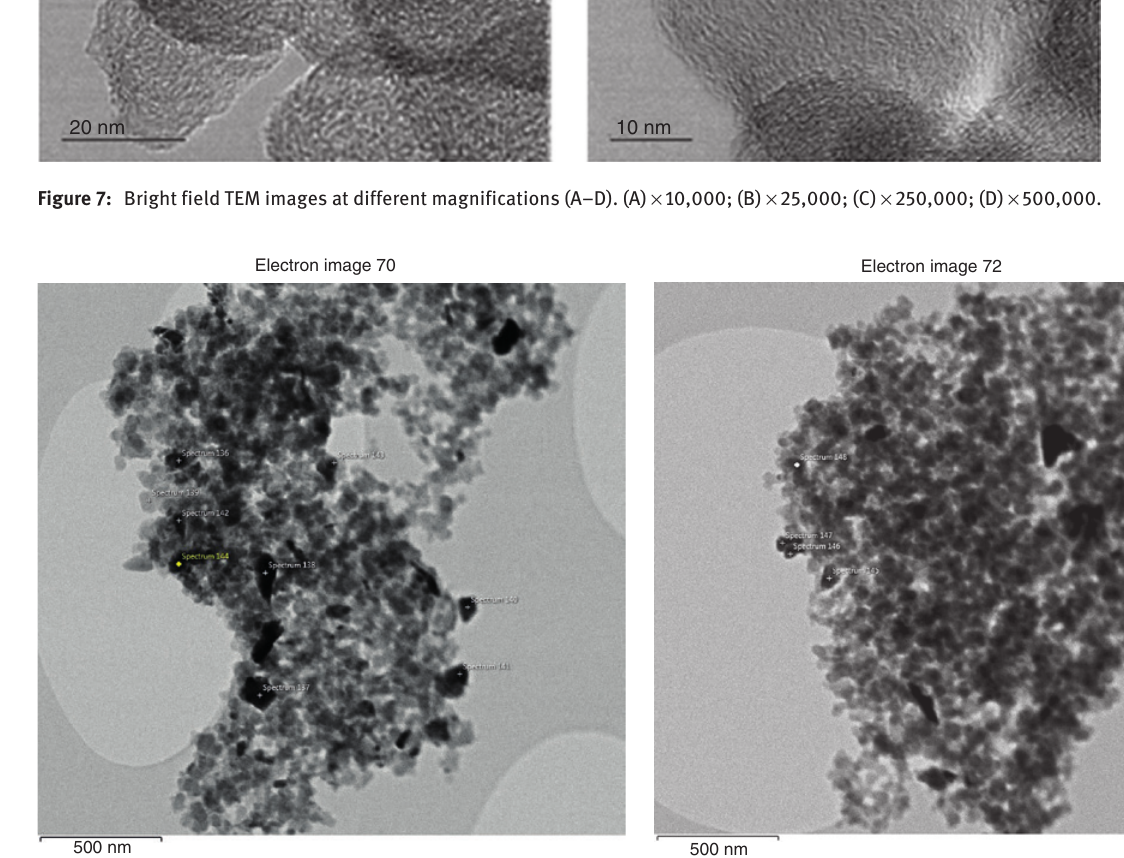
Figure 9: EDS on STEM of carbon-magnetite hybrid filler: spectra positions